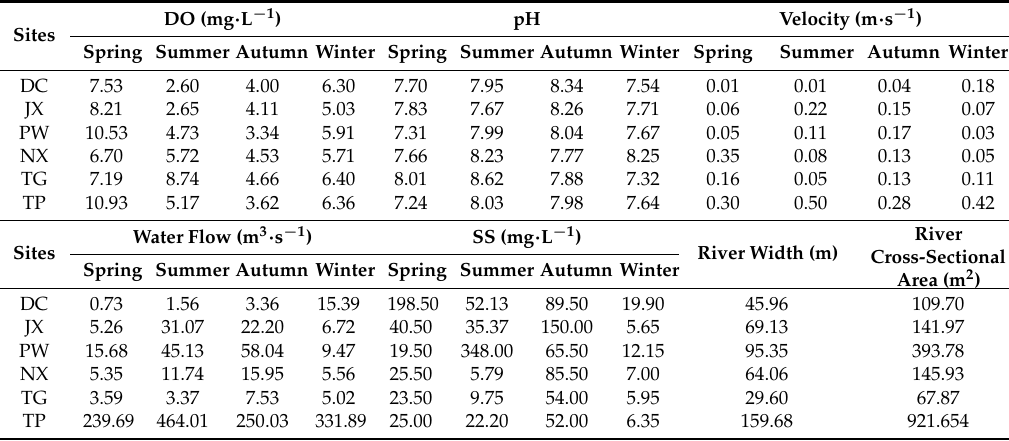
Figure 1. Sampling sites and Land Use/Land Cover (LULC) in the Taihu Basin. The LULC data set was provided by the Data Center for Resources and Environmental Sciences, Chinese Academy of Sciences (RESDC) (http://www.resdc.cn). Table 1. Physico-chemical parameters measured at each sampling site in spring, summer, autumn and winter.